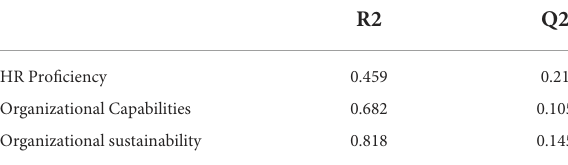
TABLE 6 R-Square values and Q-Square values for the